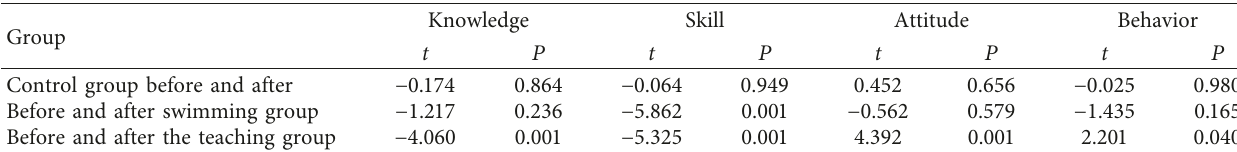
Table 3: Time simple effect